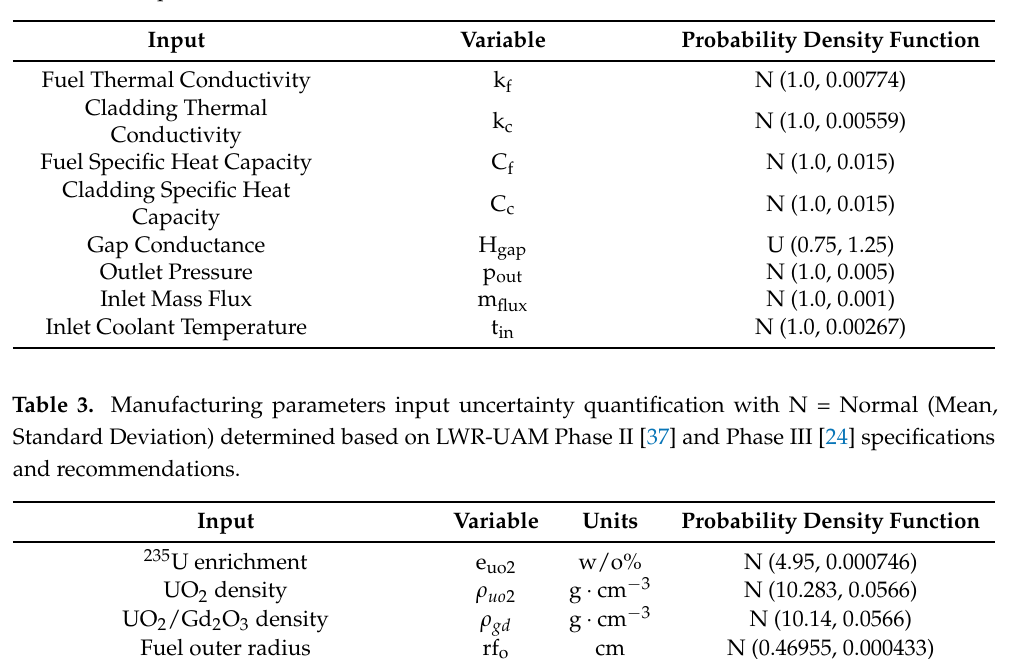
Table 2. CTF input uncertainty quantification and boundary conditions with N = Normal (Mean, Standard Deviation) and U = Uniform (Min, Max) determined based on LWR-UAM Phase II [37] and Phase III [24] specifications and recommendations.